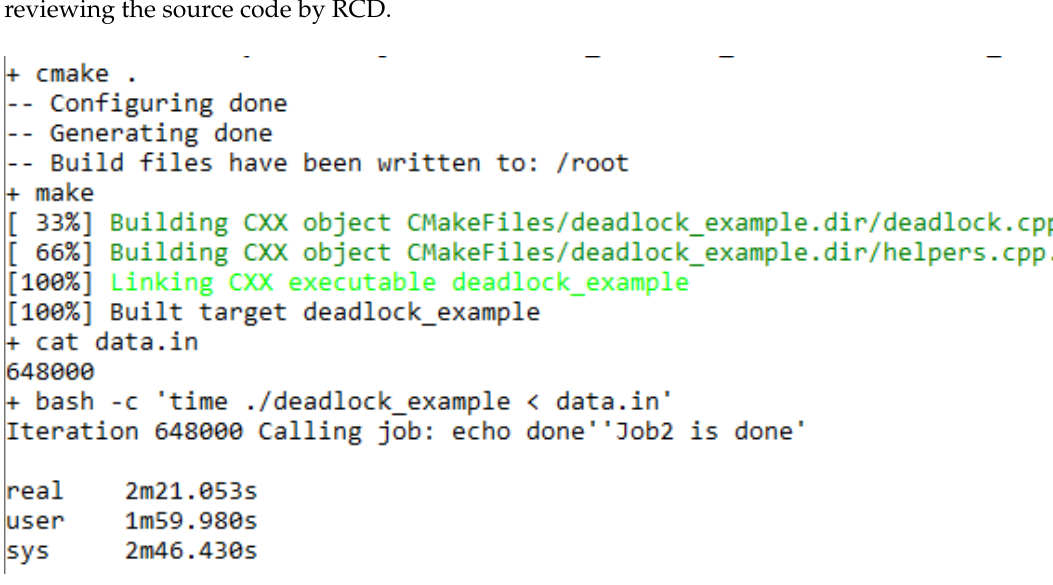
Figure 10. Screenshot of the console window with the time of a complete review of all combinations of input data for AP1